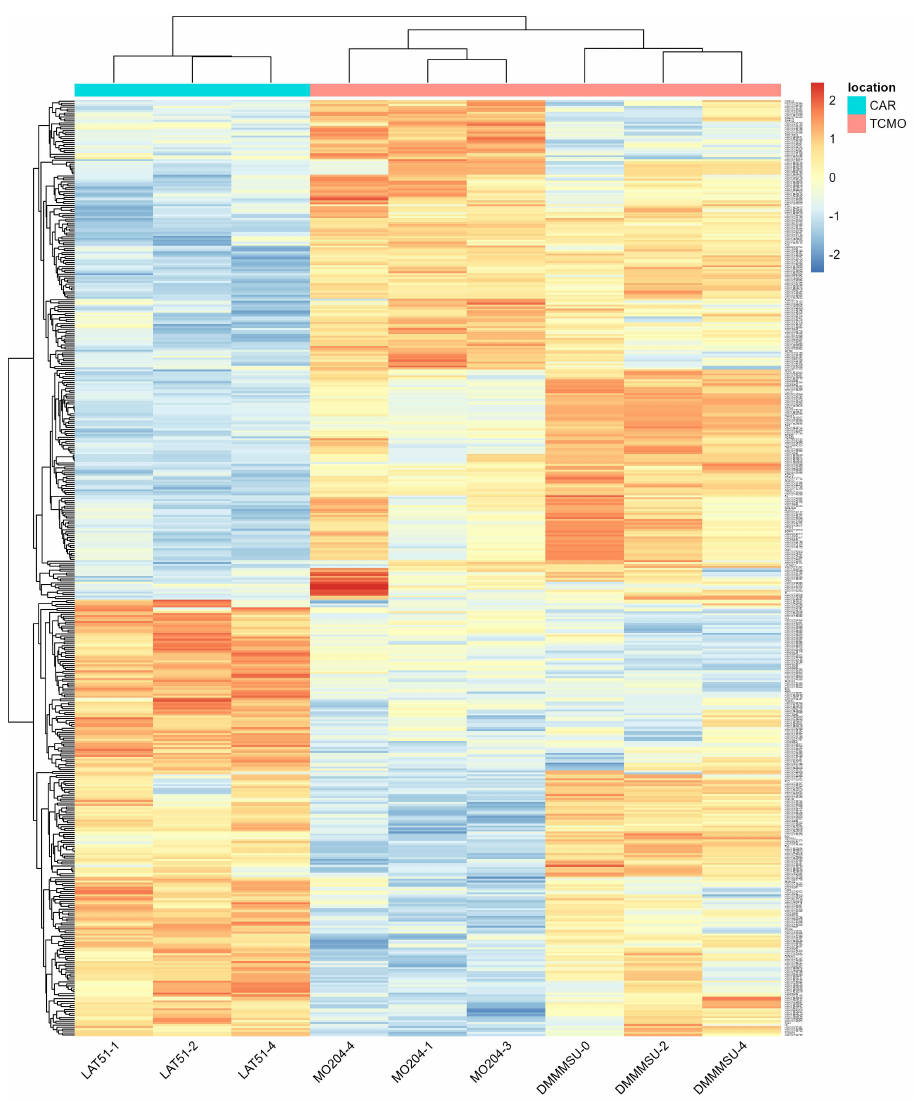
Figure 6. Heat map of the 112 DEGs from Bombyx mori with p adj < 0.1. The values shown are scaled to the distances from the average of each row